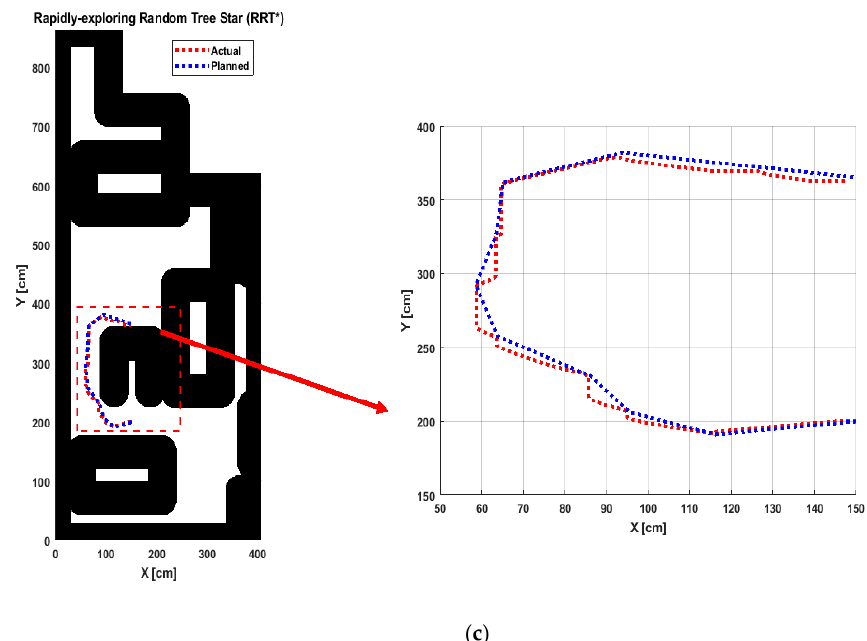
Figure 19. The experimental paths that are generated by using different path planning techniques in Map3. The blue line is the planned path, while the red line is the actual path. ( a ) The path planned by using the PRM technique. ( b ) The path planned by using the RRT technique. ( c ) The path planned by using the RRT* technique.